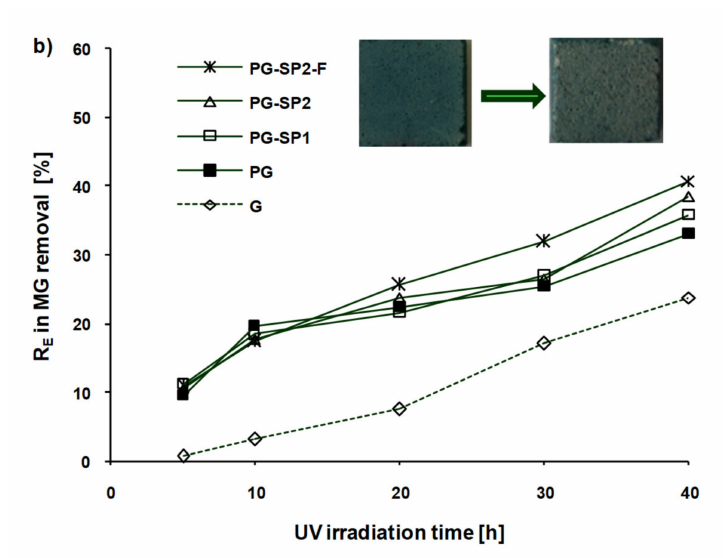
Figure 4. Self-cleaning properties of modified gypsum plasters as a function of UV irradiation time: ( a ) degradation of Reactive Orange 20; ( b ) degradation of Malachite